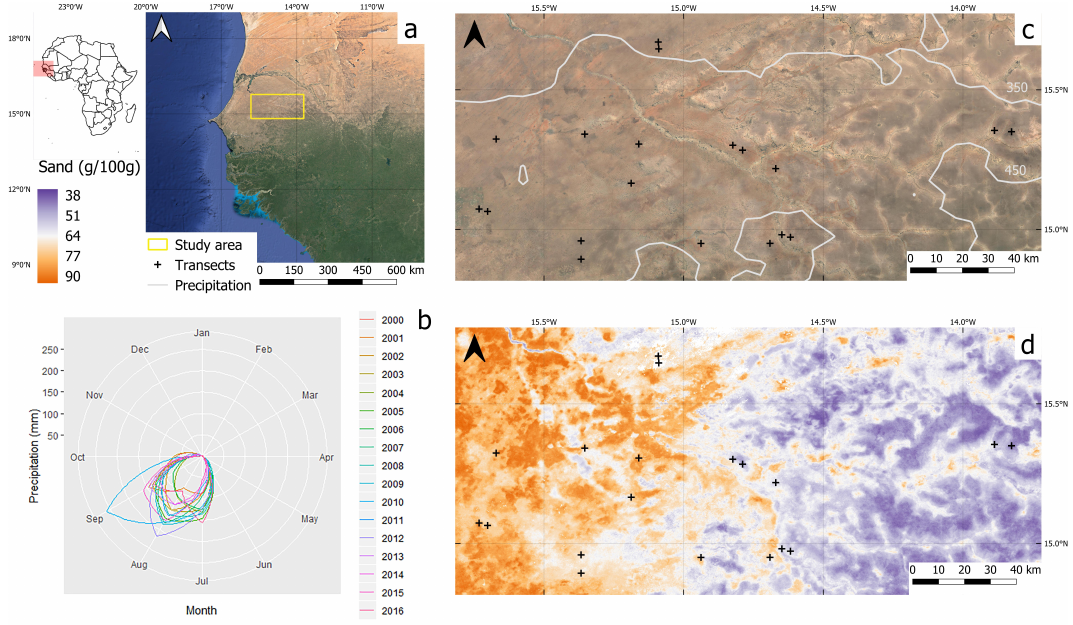
Figure 1. ( a ) Map of Senegal, with the study area highlighted in yellow [54]. ( b ) Polar seasonal plot of precipitation in the study area (2010–2016). The time series was restricted to allow visualization of possible seasonal variations in precipitation around the year of the die-off, which in fact are not observed. ( c ) Zoomed inset maps show a true-colour image [55] with precipitation isohyets (350–450 mm) and ( d ) sand content obtained from ISRIC World Soil Information [56]. While the western region has more sandy soils, the eastern region has shallow ferrugineous soils. The centre of the transects where field data were collected is shown in ( c , d